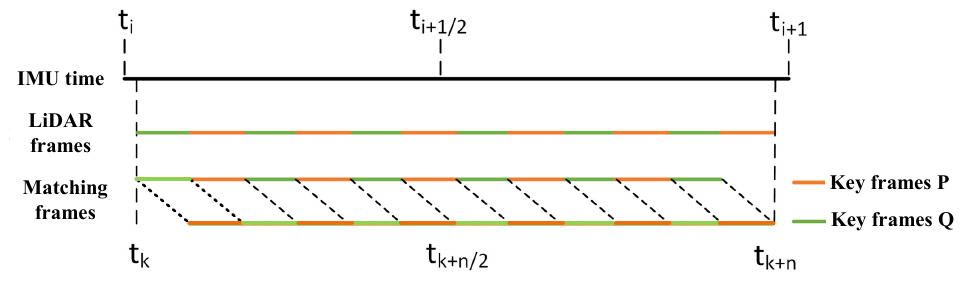
Figure 4. Continuous cross-matching strategy.